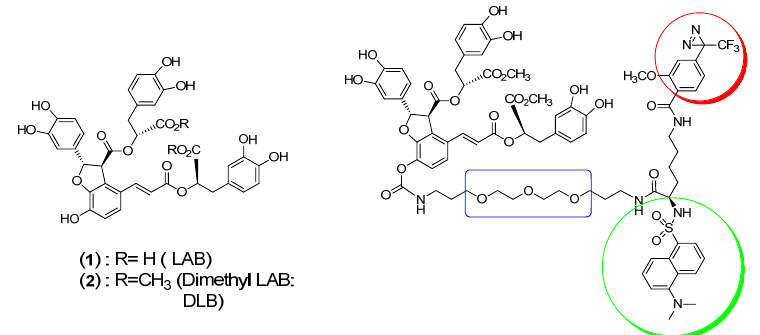
Figure 1. DLB ( 2 ) and its chemical and fluorescent probe 3